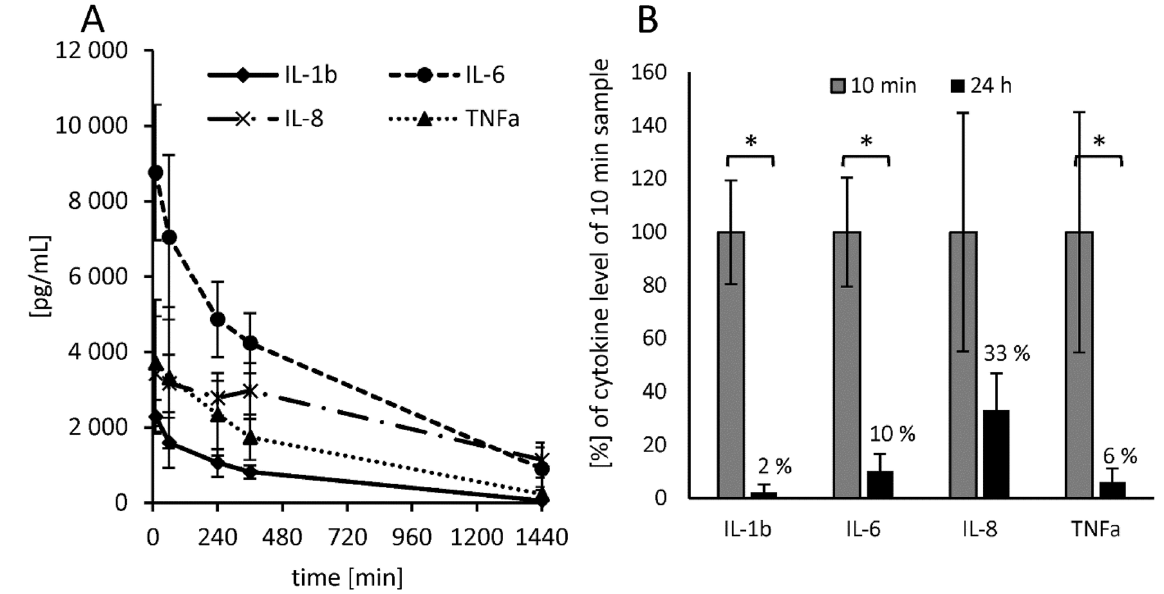
Figure 10. Effect of endotoxin neutralization on monoocyte activation in whole blood. Therefore, 2 ng/mL LPS ( E. coli ) were incubated in fresh heparin plasma for different time periods (reverse mode). All plasma samples were then mixed with blood cells from the same donor in a 1:1 ratio and incubated at 37 °C for 4 h. After incubation cytokine levels were determined by ELISA. Mean values ± standard deviation are shown ( A ). The bars marked with * indicate a significant (p ≤ 0.05) reduction of secreted cytokine levels in blood between 10 min and 24 h LPS pre-incubation ( B